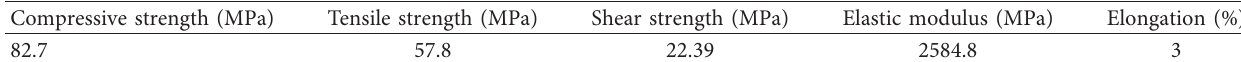
Table 4: Mechanical Properties of epoxy